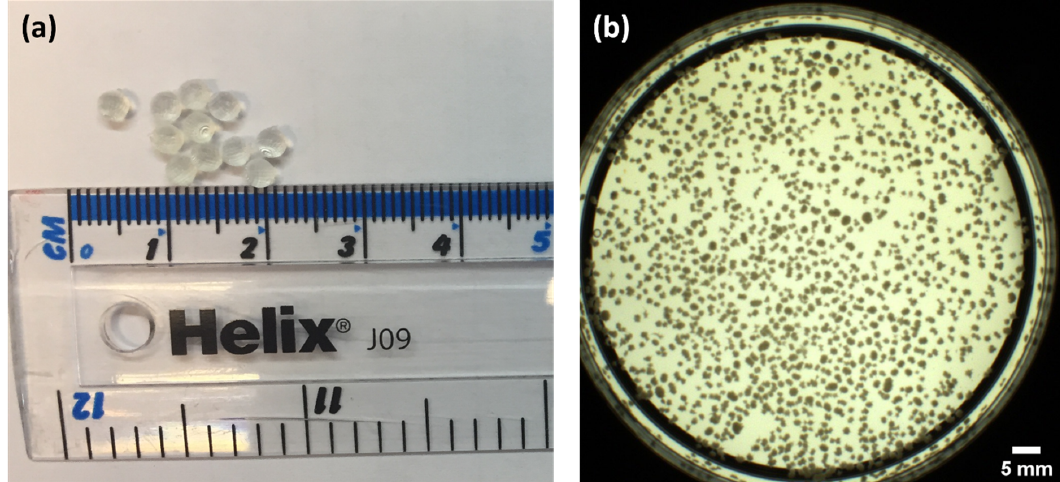
Figure 2. Images showing the different morphology of ( a ) 3D-printed particles and ( b ) fungal pellets. Table 1. Details of the solid phases used in liquid–solid fluidization